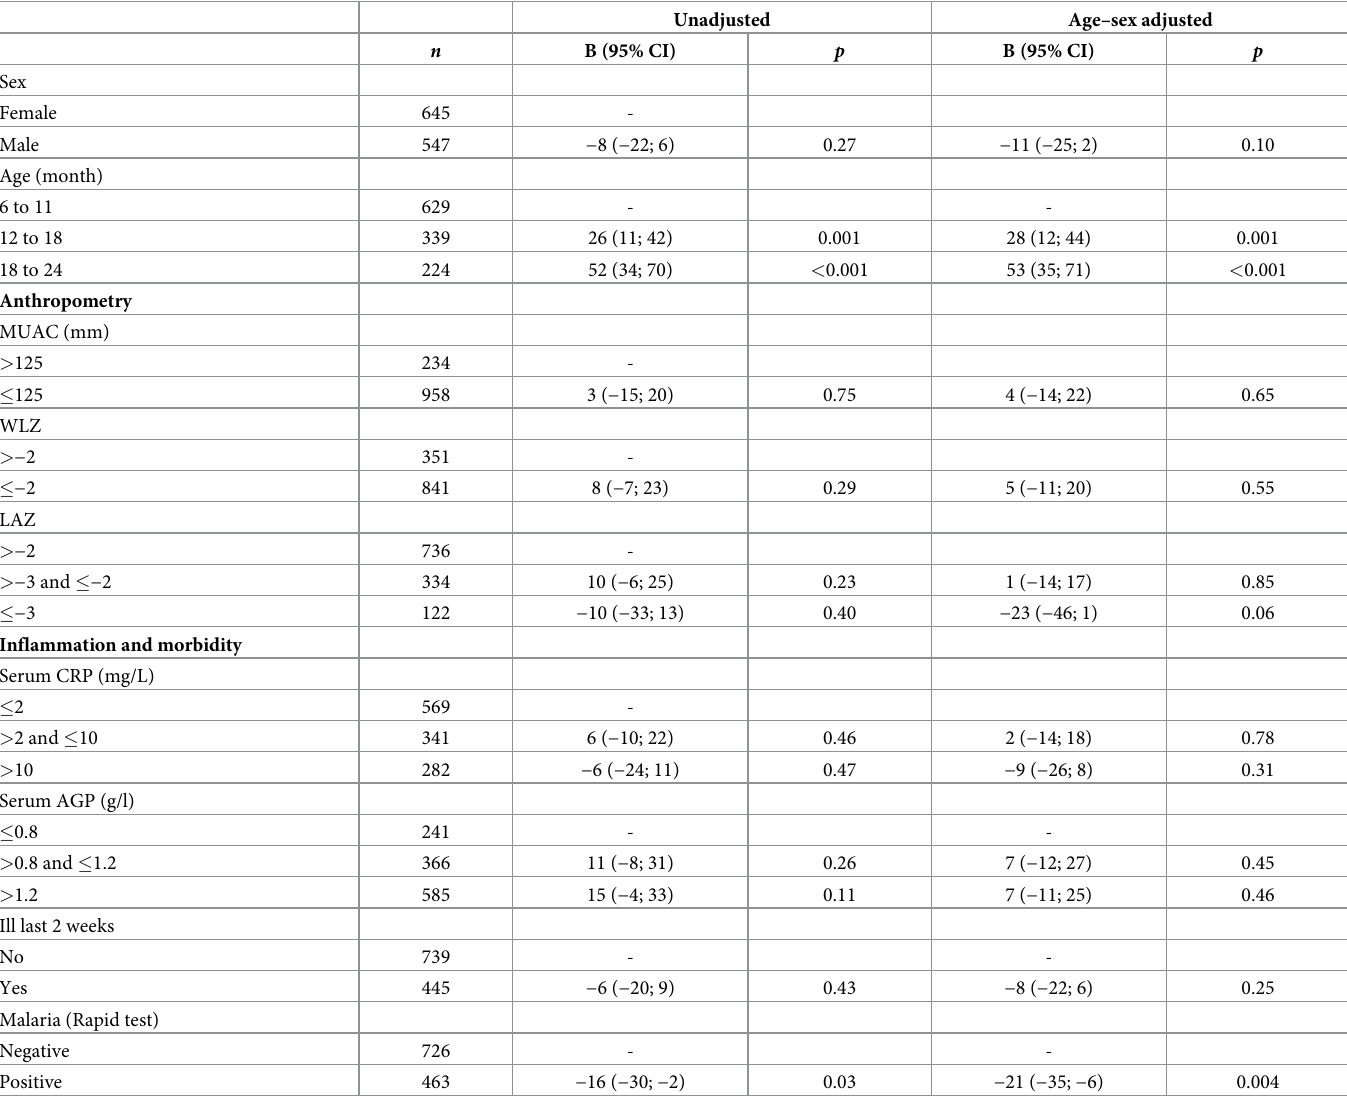
Table 2. Growth, inflammation, and morbidity as correlates of baseline SC (pmol/L) in 1,192 children with MAM 1 .